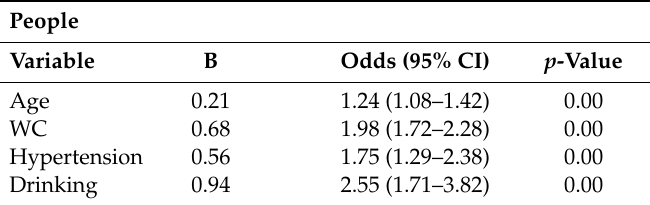
Table A4. Multivariate Analysis of people with